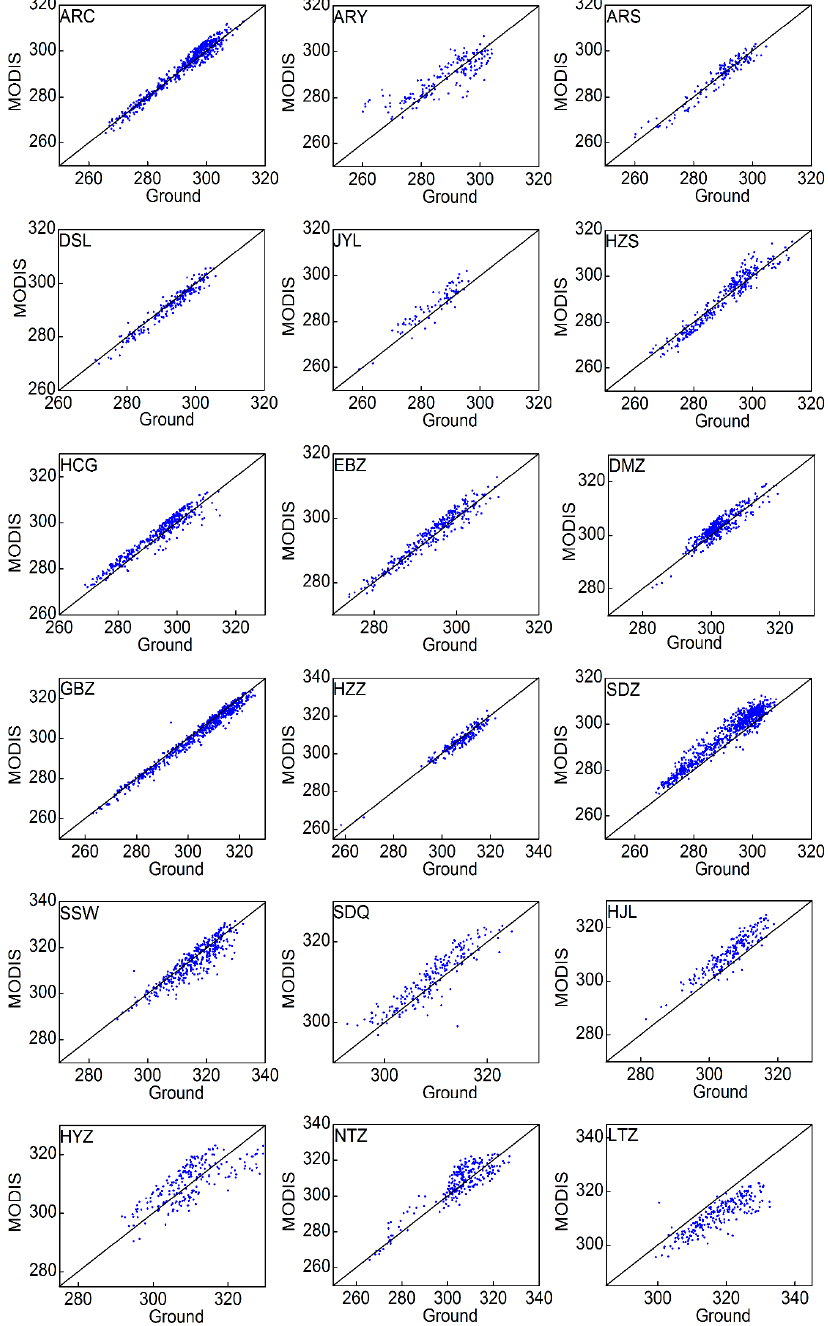
Figure 9. Scatterplots of the daytime comparison results of the LSTs from MODIS and the LST measurements at the eighteen HiWATER sites.